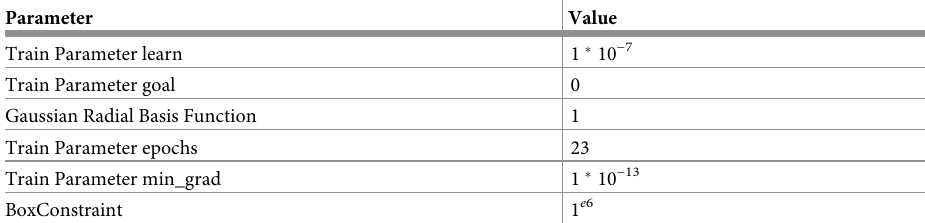
Table 2. Initial